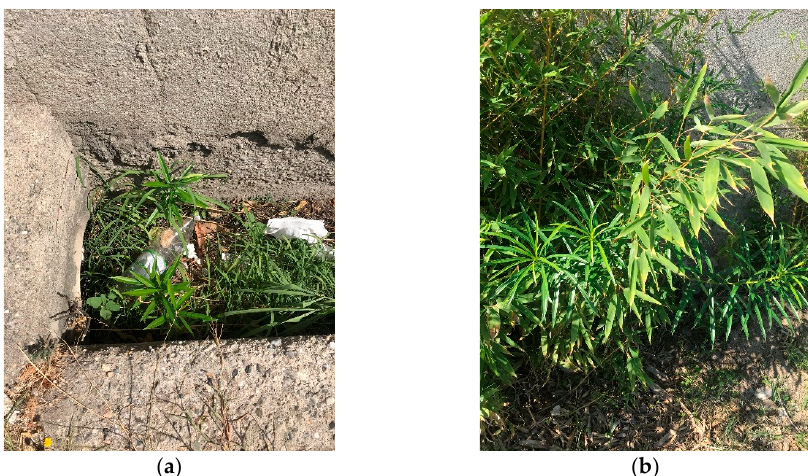
Figure A2. Brugmansia aurea Lagerh. found in a roadside in Brancaleone (Reggio Calabria province): ( a ) flower; ( b ) several individuals of B. aurea mixed with Oxalis pes-caprae L. (yellow arrow) and Opuntia ficus-indica (L.) Mill. (green arrow) (Photographs VLA Laface).